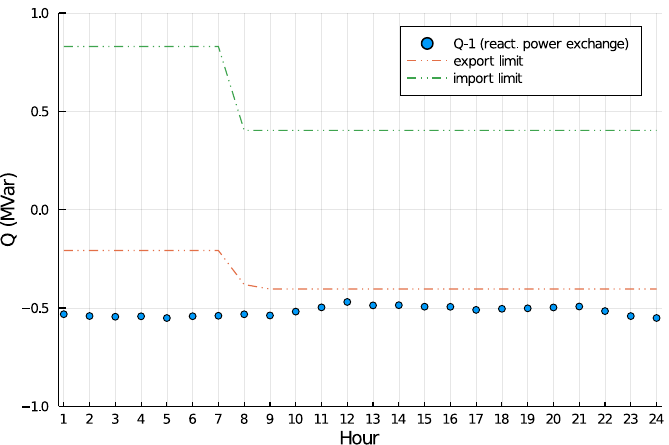
Figure 11. Reactive power exchange with the transmission system for the entire day when no reactive power support from DER is utilised (zero